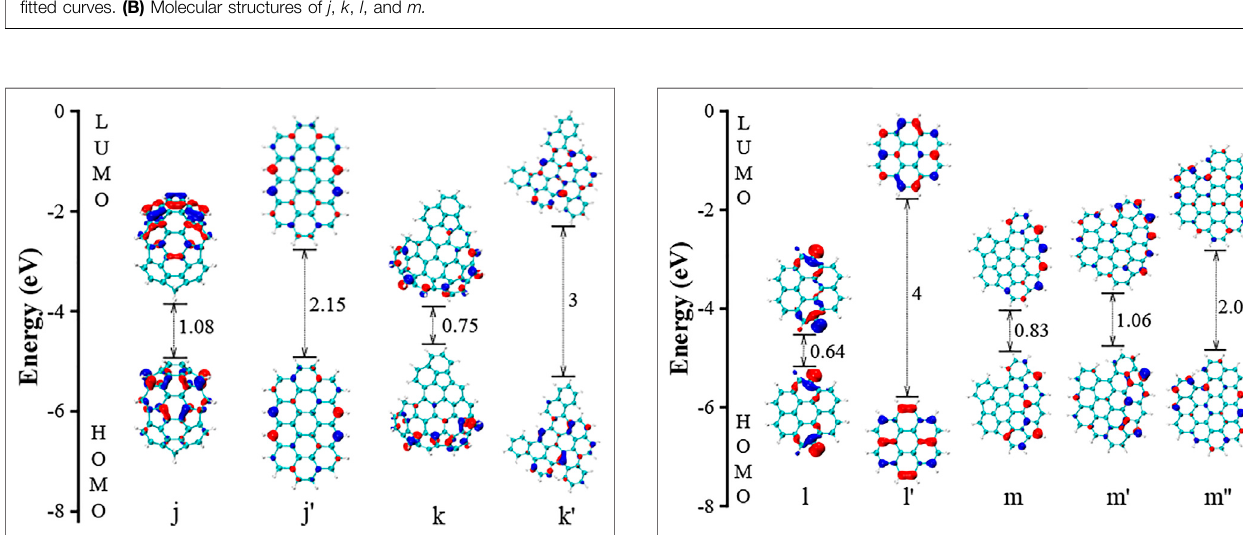
FIGURE 7 | (A) HOMO-LUMO gaps of PAH molecules with planar and nonplanar structures. The curves presented as solid line are obtained fi tting with E